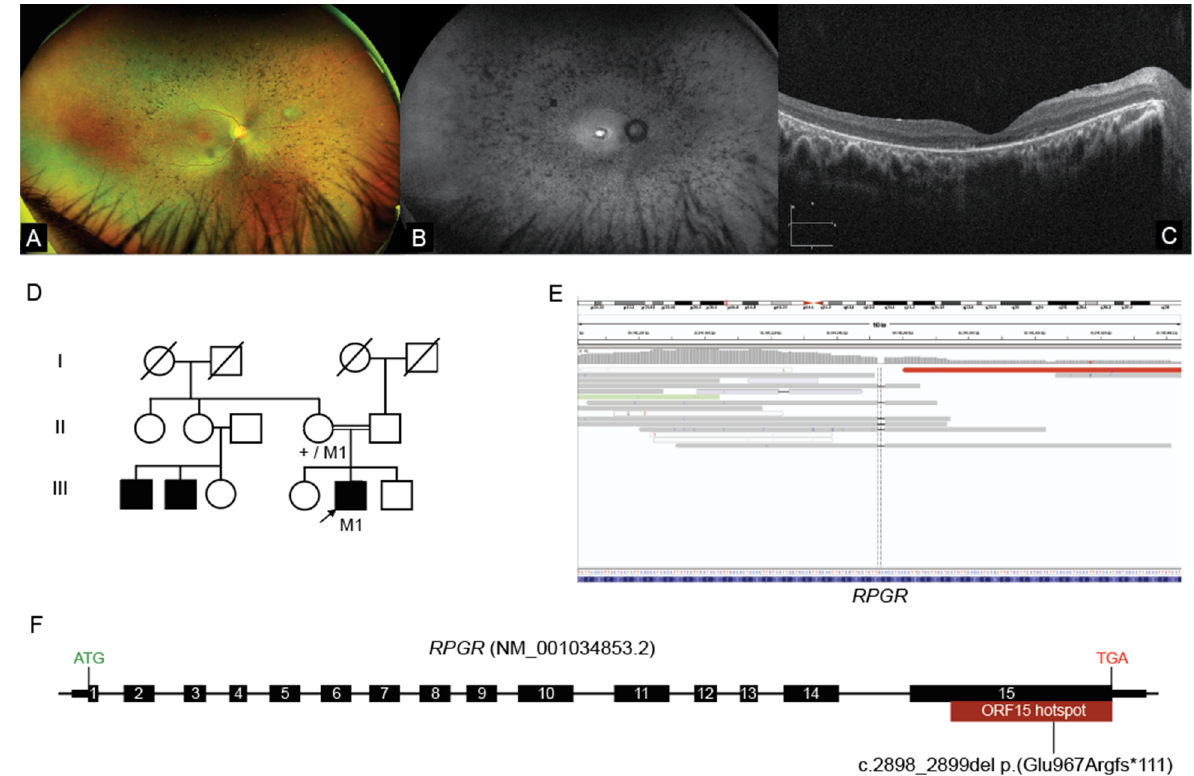
Figure 2. WGS identifies loss of function variant within the RPGR mutation hotspot ORF15 ( A ) Ultra-wide-field pseudo colour fundus images showing widespread retinal pigment migration in a “bone spicule” pattern with associated outer retinal atrophy; ( B ) UWF-FAF showing a central area hyper autofluorescence surrounded by a ring of incomplete hypo autofluorescence. Beyond the vascular arcades there are speckled areas of hypo autofluorescence of varying density; ( C ) OCT assessment shows preservation of an attenuated ellipsoid zone (EZ) and outer retinal structures at the fovea. In the para macular regions there is significant attenuation to loss of the EZ line representing outer retinal structures. ( D ) Pedigree of Family 2, M1 = RPGR ORF15 mutant allele, + = wild type allele; ( E ) IGV screenshot showing coverage of the RPGR (NM_001034853.2):c.2898_2899del p.(Glu967Argfs*111) variant detected on WGS (dashed vertical lines), located within the highly repetitive GC-rich ORF15 locus; ( F ) Illustration of the RPGR ORF15 gene structure depicting the location of the variant identified within the low complexity region of the ORF15 mutation hotspot. OCT Optical Coherence tomography, UWF-FAF Ultra-wide field fundus autofluorescence, EZ ellipsoid zone.